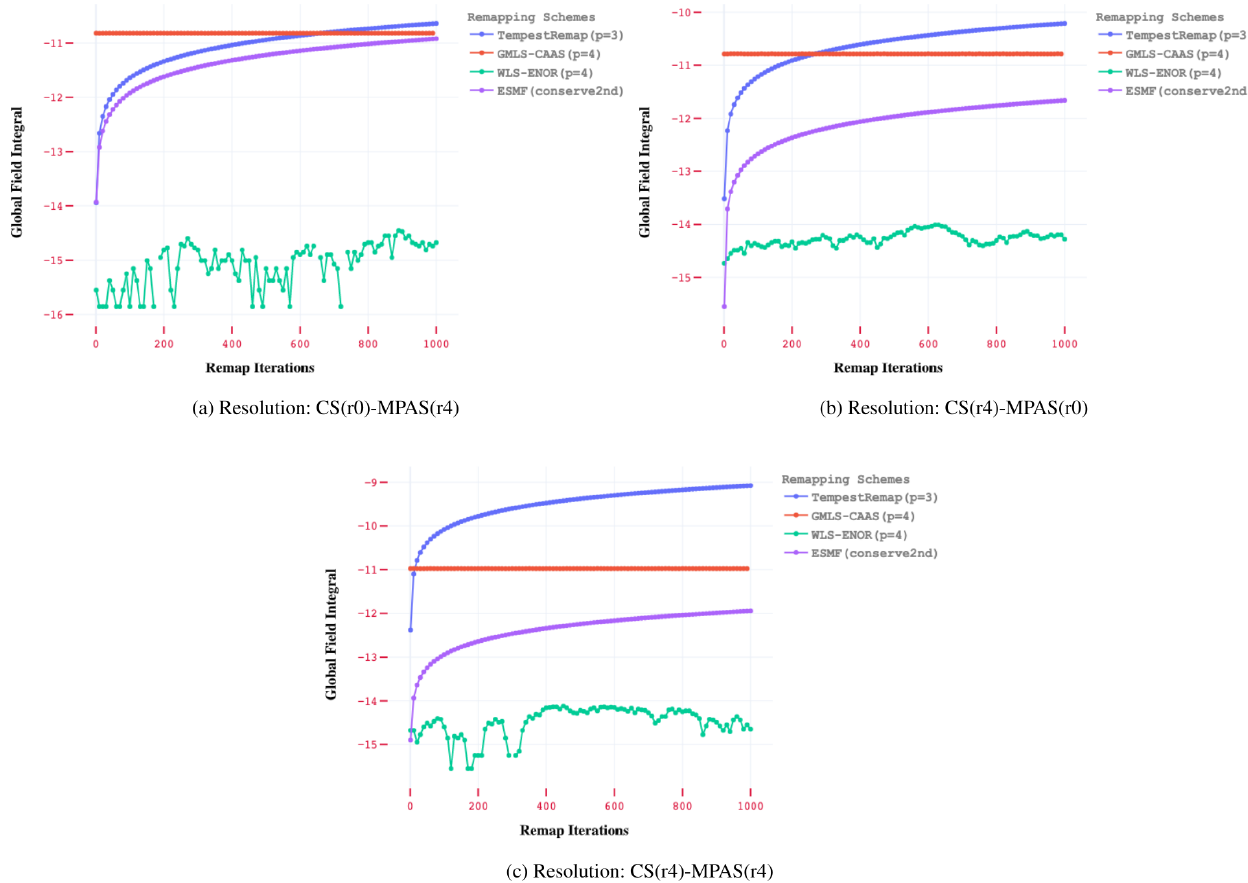
Figure 7. Global conservation error metric for the TPW field on CS-MPAS meshes with different resolutions in semi-log